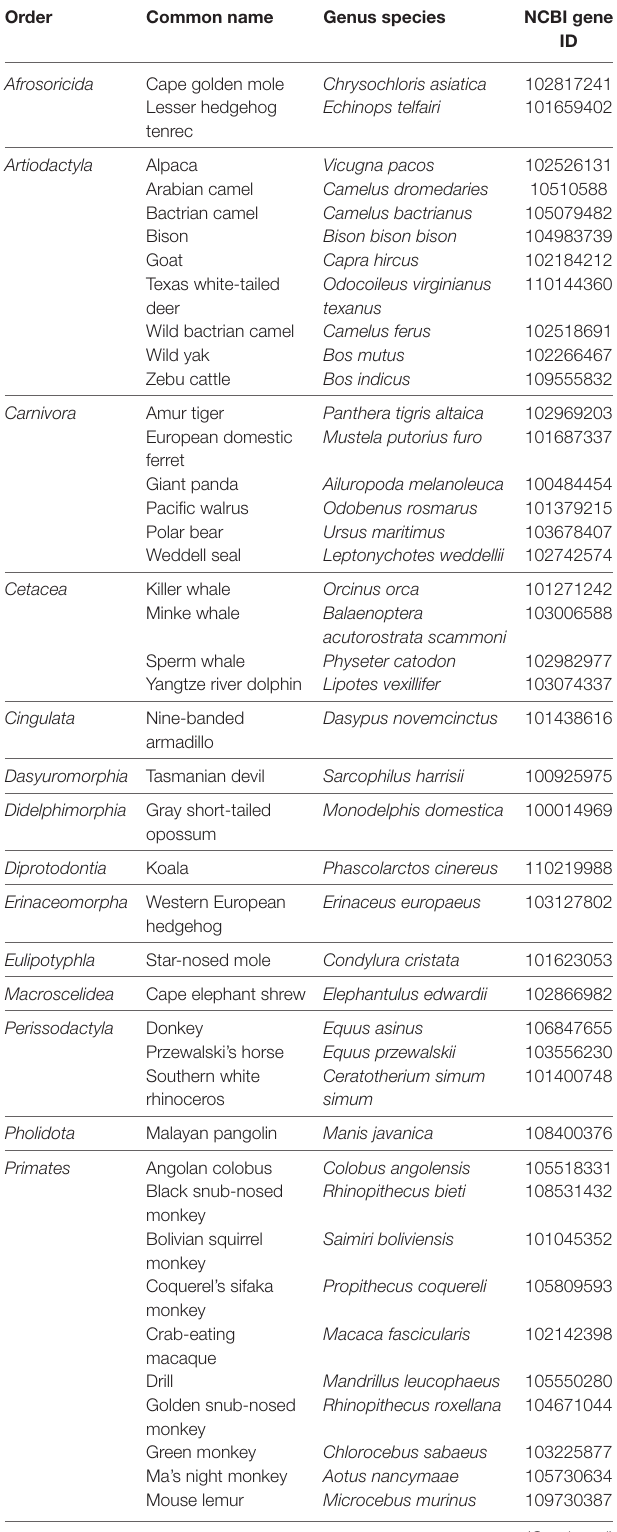
TABLe 5 | Identification of the GnRHR2 gene within 61 additional mammals via NCBI gene database